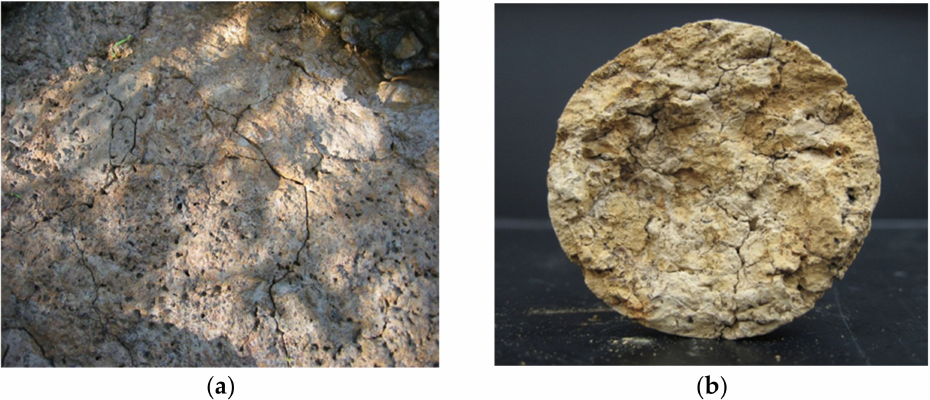
Figure 3. Evidence of structured soils: ( a ) surface condition of CL soil in the field, ( b ) small-scale structured layer on a dried